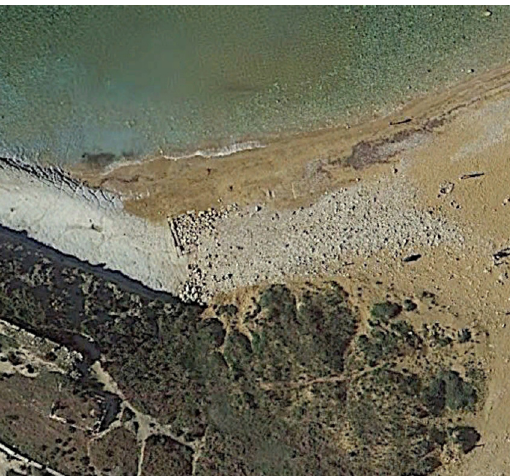
Figure 7: A screen shot from Google Earth capturing the newly uncovered ashlar